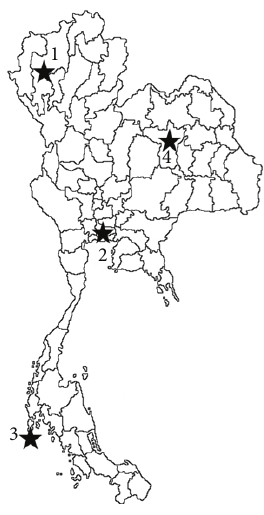
Figure 1: Geographic distribution of cases and clinics/hospitals included in the study in